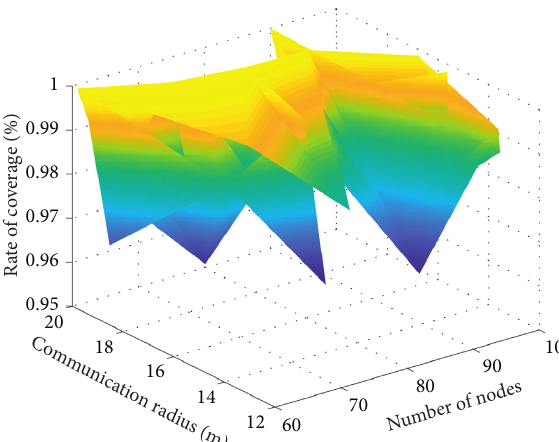
Figure 3: Relationship between the number of nodes, communication radius, and